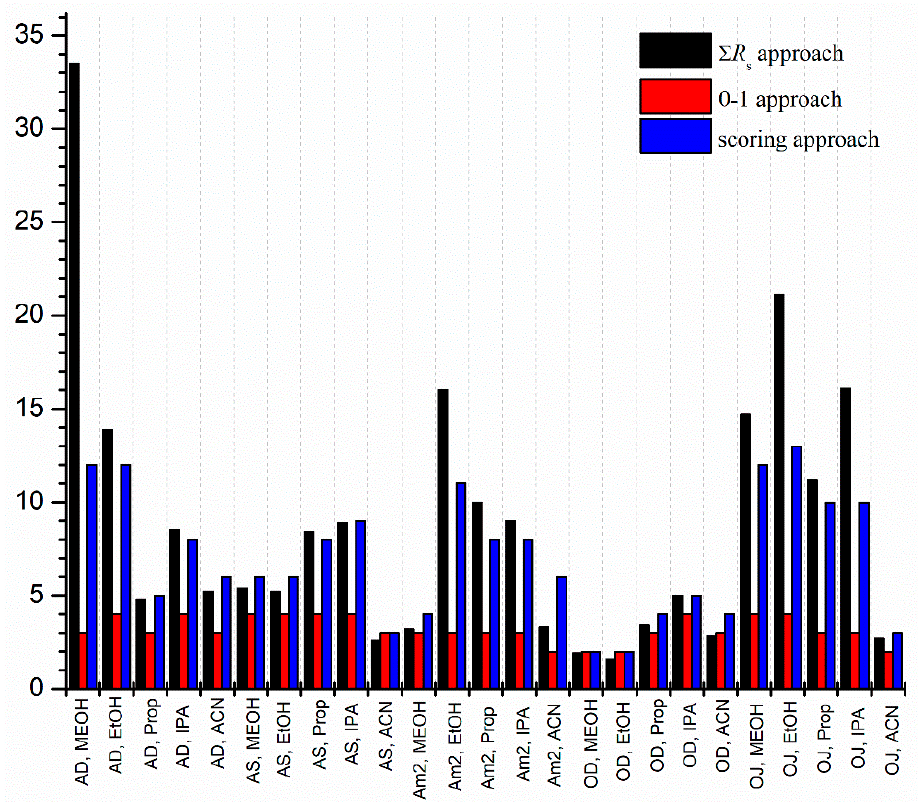
Figure 3. Characterization of the success of the applied separation system. Separation conditions were as indicated in Section 3.